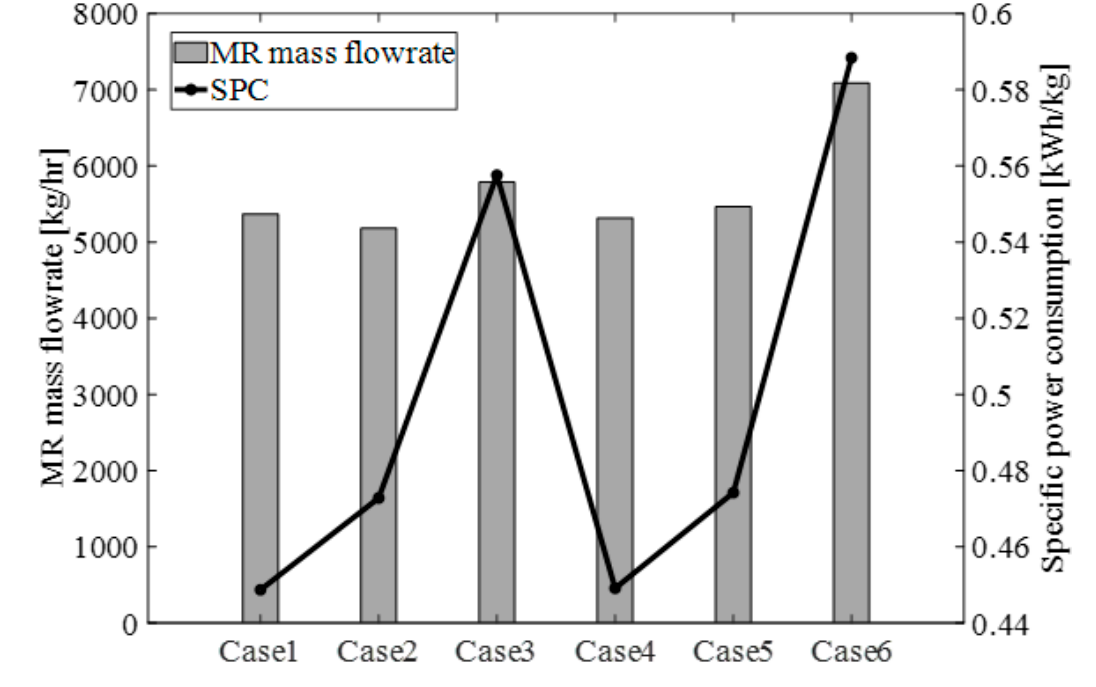
Figure 2. The optimization results. Table 3. The optimization results.